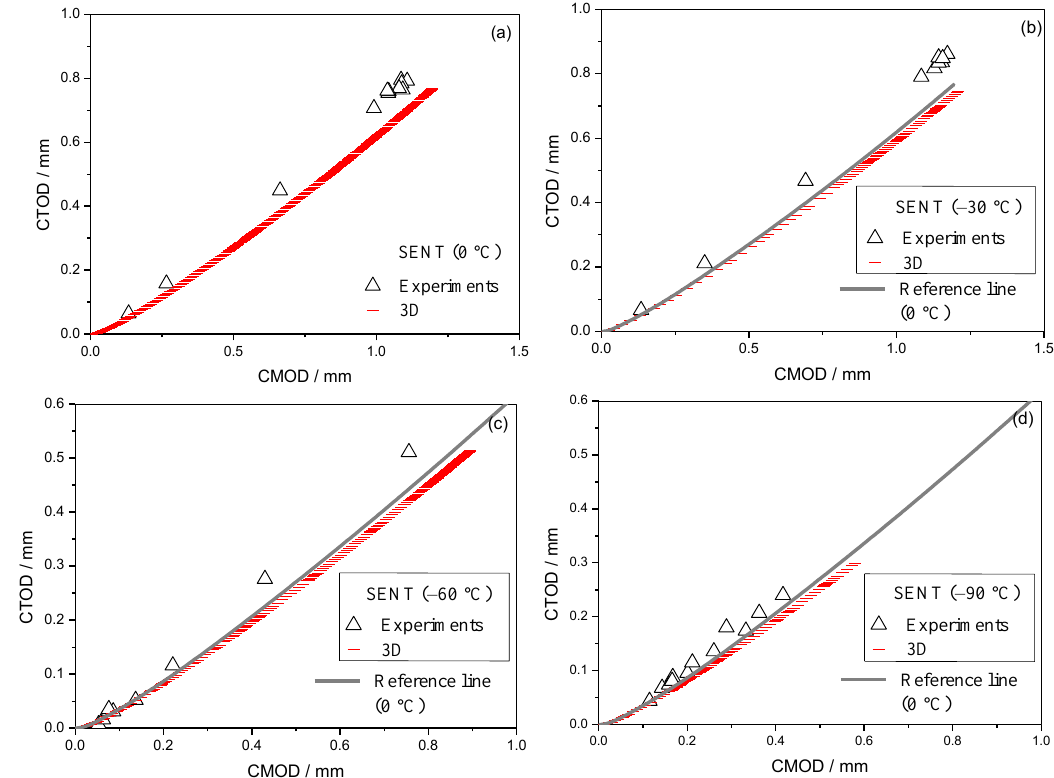
Figure 11. CTOD vs. CMOD relations from experiments and 3D FE analyses for SENT specimens without crack growth at different temperatures, ( a ) 0 °C, ( b ) −30 °C, ( c ) −60 °C, and ( d ) −90 °C.